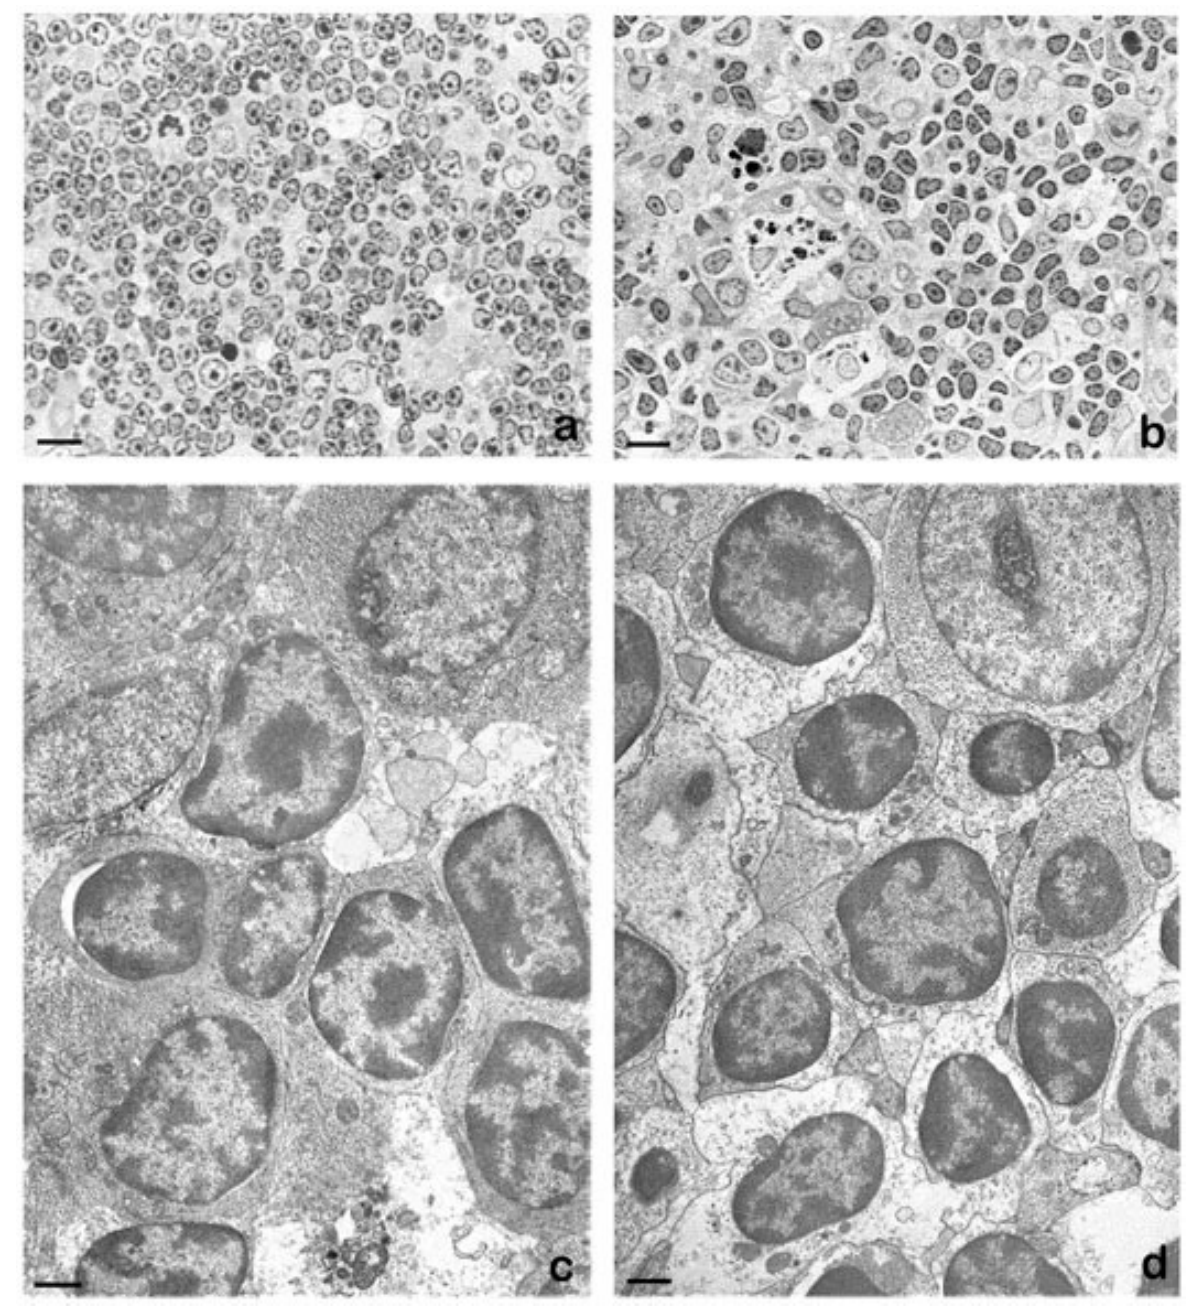
FIGURE 1 . Light (a,b) and electron microscopy (c,d) of thymocytes from 10-month-old rats housed in a DL (a,c) or under CL (b,d). Exposure to CL increases the amount of degenerative features. Bar: 10 µ m (a,b), 1 µ m